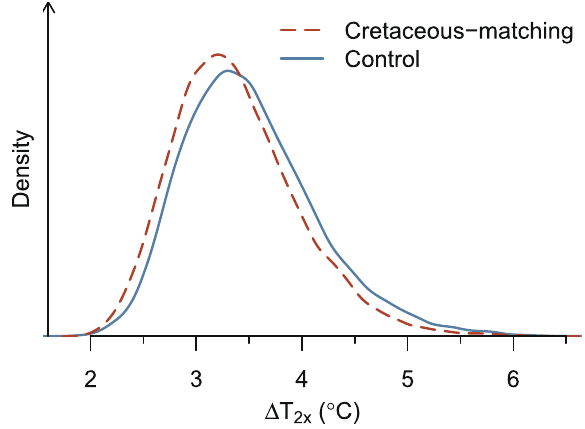
Fig. 5 A posteriori probability density for Earth-system sensitivity parameter ( Δ T 2 x ). Shown are the densities for the original calibration experiment using the 30 %outbound threshold and both CO 2 and temperature data (solid blue line) and the experiment, where the simulated temperature is forced to agree with the data compilation of ref. 12 in the 90 Myr ago time step (dashed red